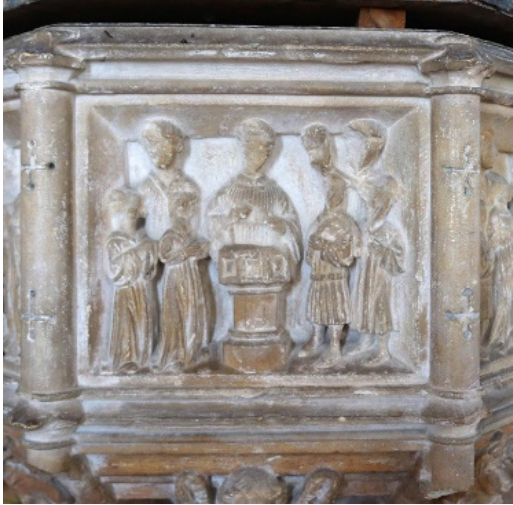
Figure 13. Baptism. Source: Bob Mitchell.